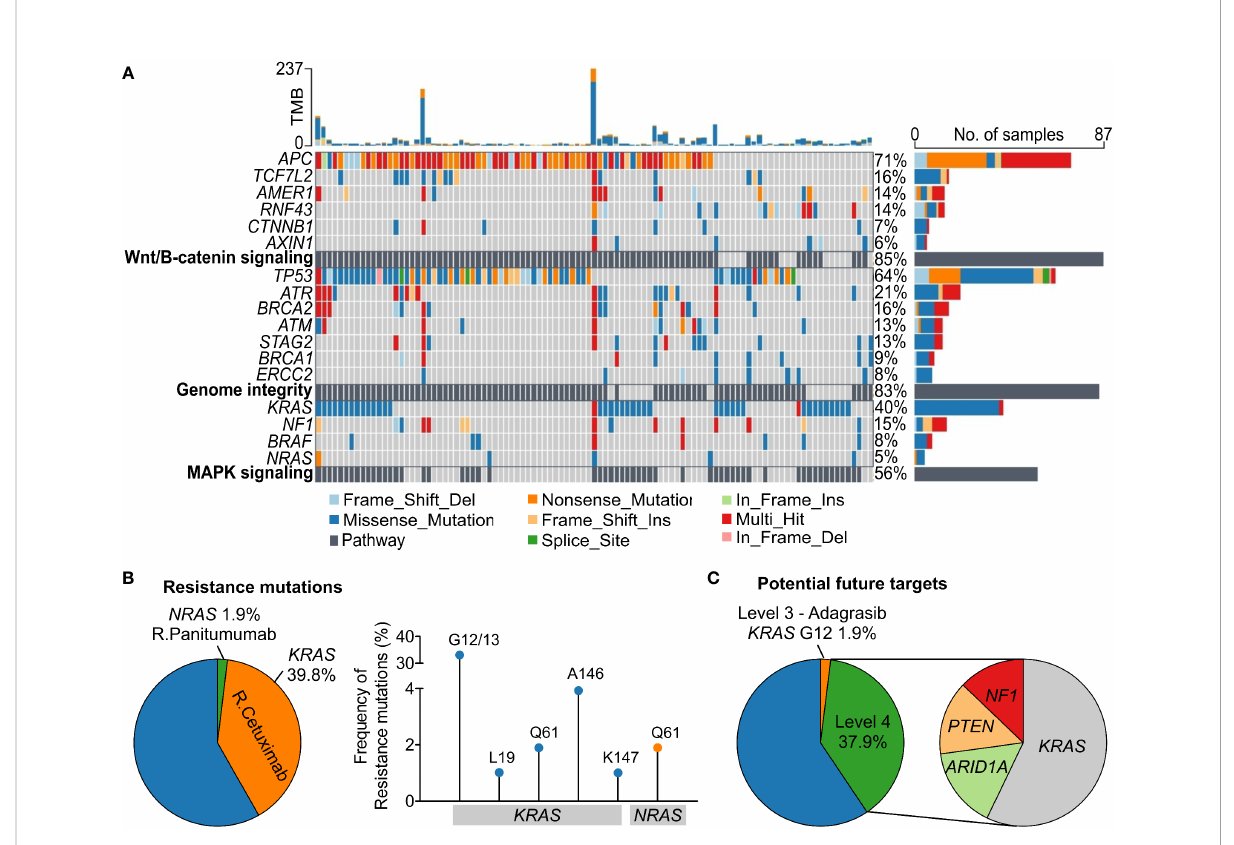
FIGURE 3 Oncogenic signaling pathways and actionable alterations in the Vietnamese colorectal cancer patients. (A) The top three signaling pathways with frequent oncogenic alterations in our cohort were Wnt/ b -catenin signaling, genome integrity, and MAPK signaling. (B) Proportions of patients harboring mutations in KRAS and NRAS predictive of resistance to Cetuximab and Panitumumab respectively. Frequency of the speci fi c resistance mutations was also illustrated. (C) Proportions of patients carrying mutations that are candidate biomarkers for response to drugs with compelling clinical evidence (level 3) or laboratory evidence (level 4) as classi fi ed by the OncoKB